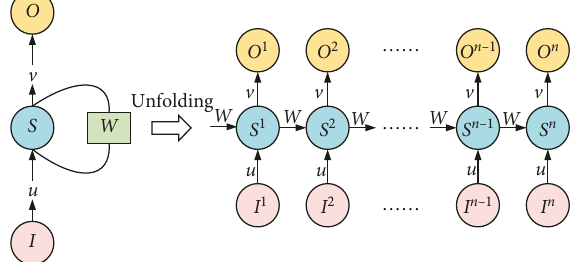
Figure 5: Structure of a recurrent neural network